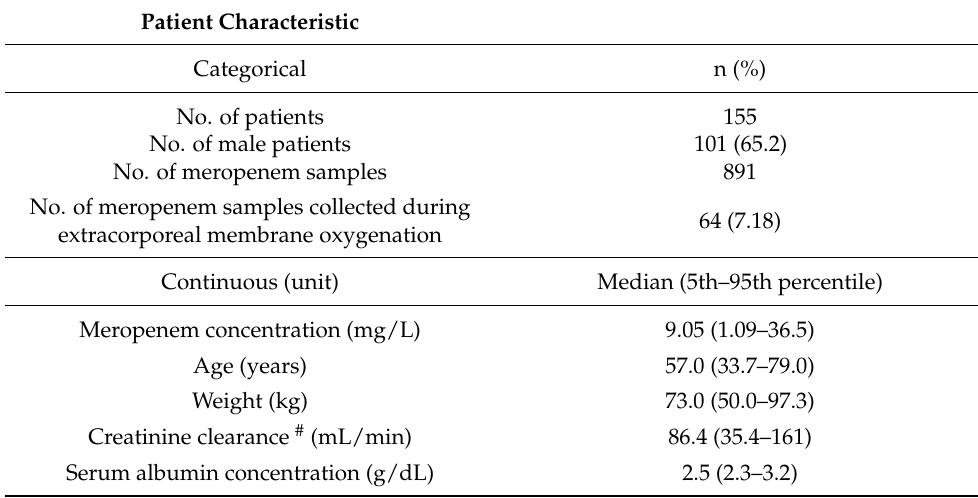
Table 1. Patient characteristics of evaluation